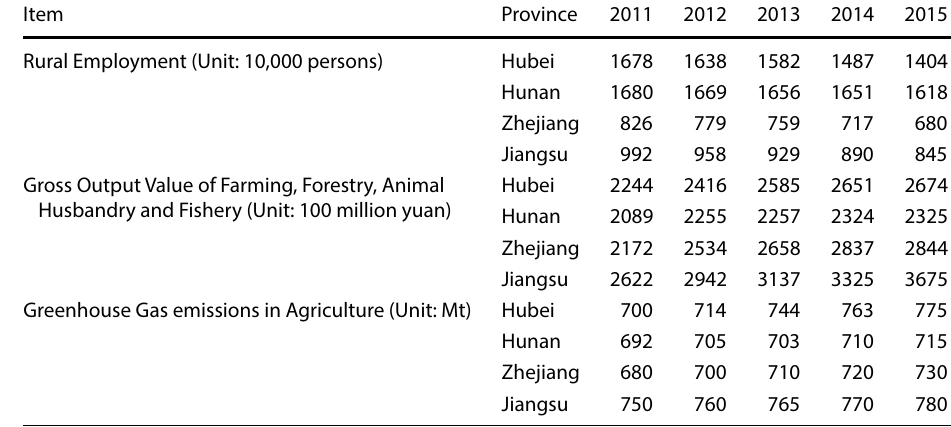
indicators of agricultural development of